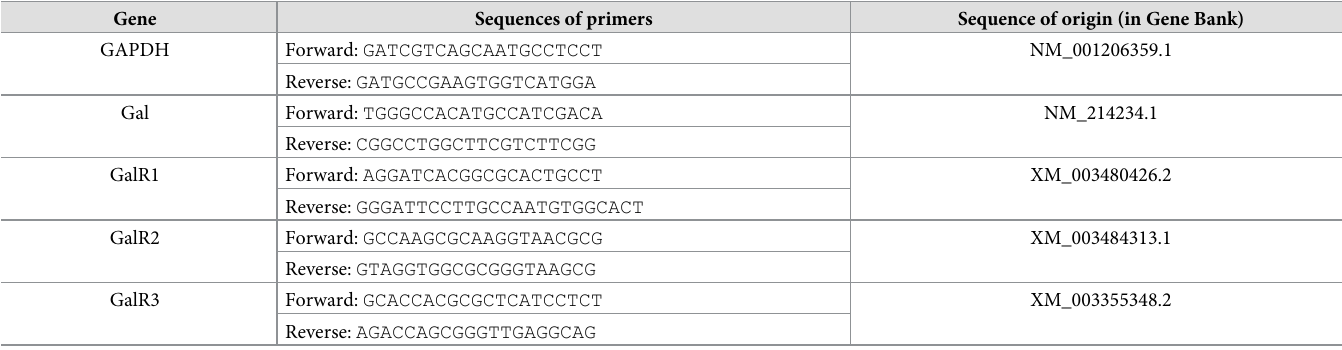
Table 1. Sequences of primers used in the real-time PCR. Gene Sequences of